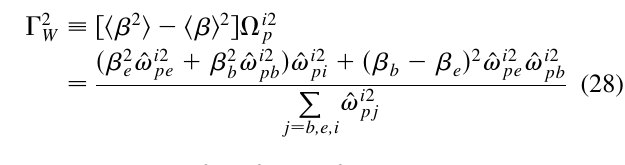
versus mode number n , and (b) eigenfunction (cid:31) ^ E W (cid:7) r (cid:7) 0 : 2 , (cid:30) i = 3 , (cid:15) r =c (cid:7) 1 = 3 , and (cid:30) 0 b w b b p